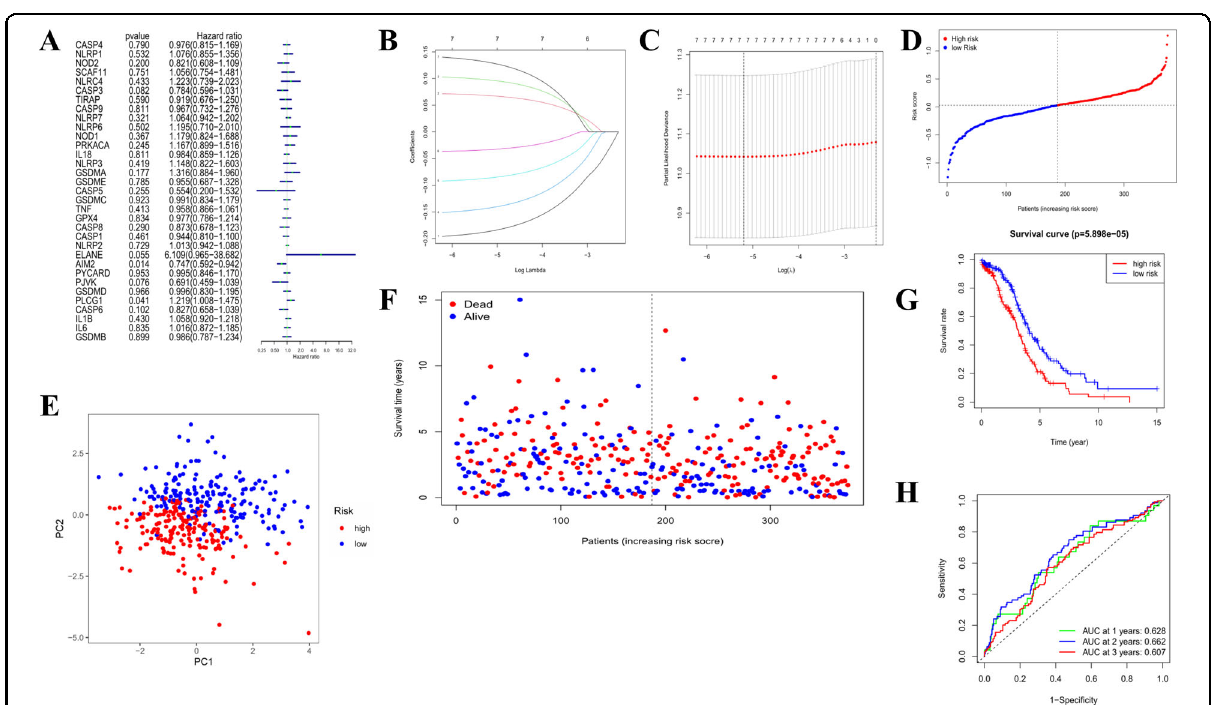
Fig. 3 Construction of risk signature in the TCGA cohort. A Univariate cox regression analysis of OS for each pyroptosis-related gene, and 7 genes with P < 0.2. B LASSO regression of the 7 OS-related genes. C Cross-validation for tuning the parameter selection in the LASSO regression. D Distribution of patients based on the risk score. E PCA plot for OCs based on the risk score. F The survival status for each patient (low-risk population: on the left side of the dotted line; high-risk population: on the right side of the dotted line). G Kaplan – Meier curves for the OS of patients in the high- and low-risk groups. H ROC curves demonstrated the predictive ef fi ciency of the risk